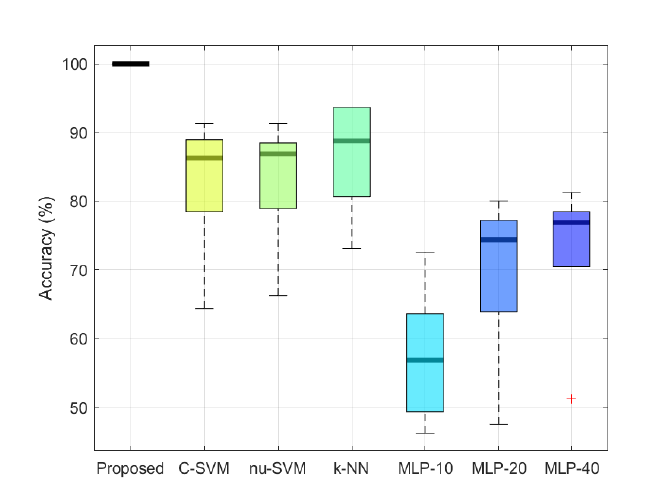
Figure 15. Accuracy boxplots for each method over 5-fold cross-validation.